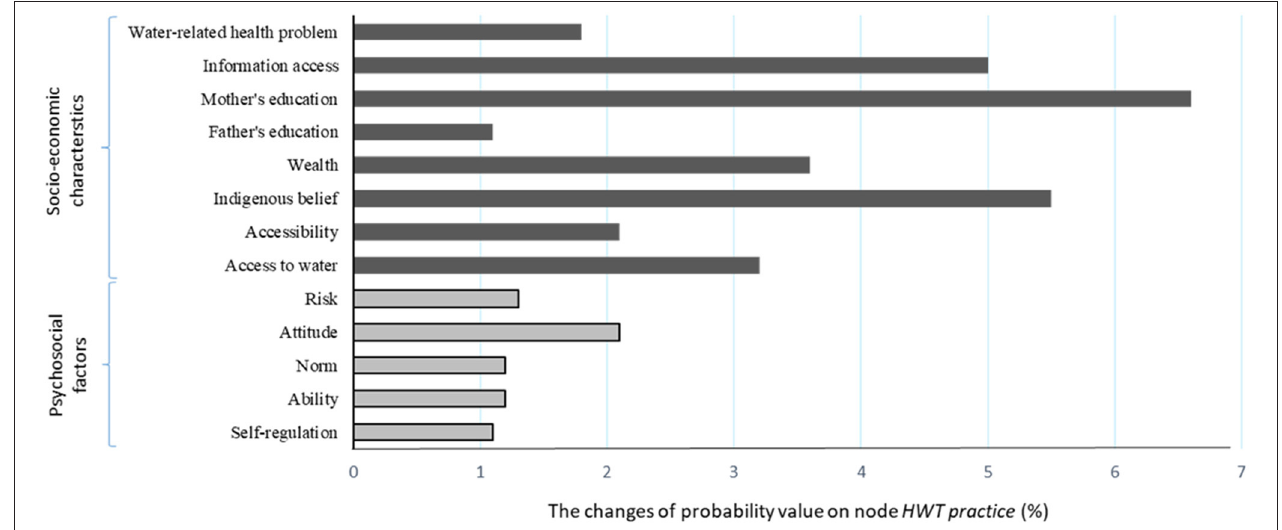
FIGURE 6 | Sensitivity analysis of individual nodes on the output node HWT practice